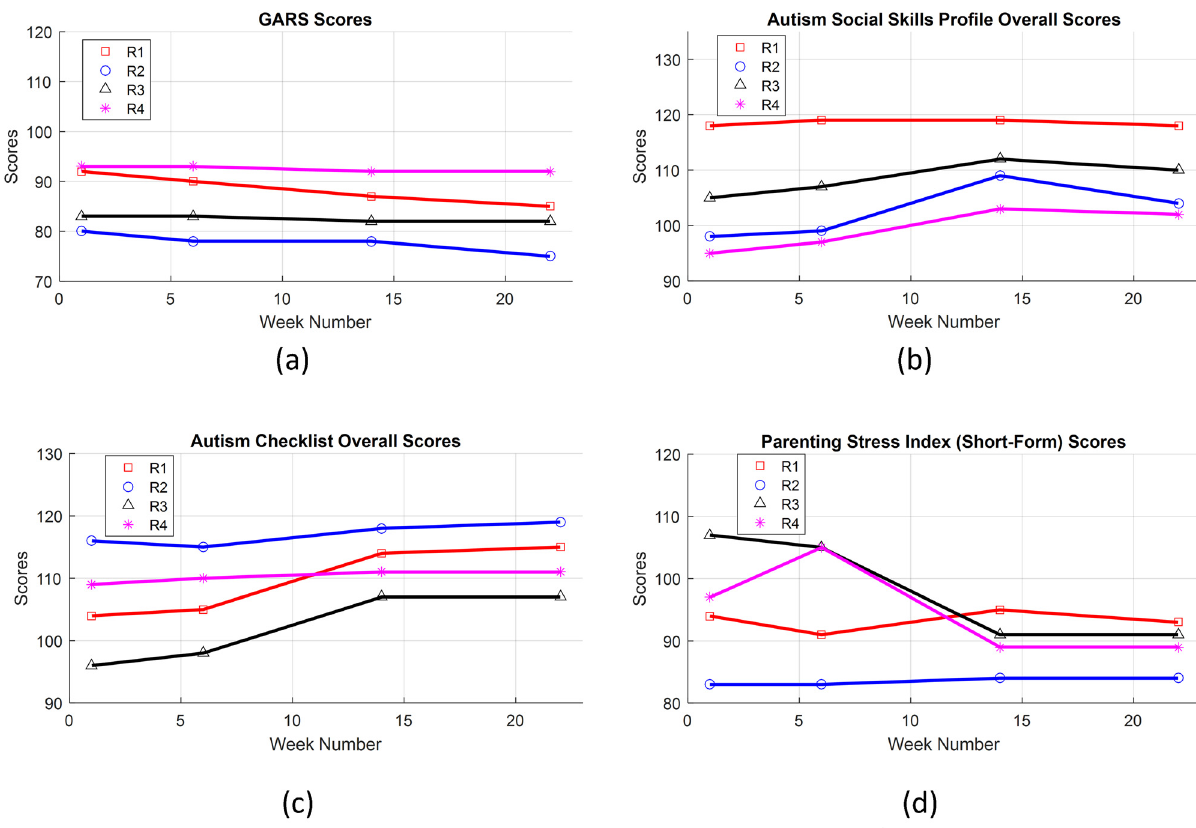
Figure 6: The Questionnaires Scores of the LF subjects in the Baseline ( Week #1 ) , Pre - Test ( Week #6 ) , Post - Test ( Week #14 ) , and Follow - up Test ( Week #22 ) fi lled in by the parents: ( a ) overall GARS scores ( indicating autism severity ) , ( b ) ASSP overall scores, ( c ) Autism Checklist overall scores, and ( d ) PSI - SF